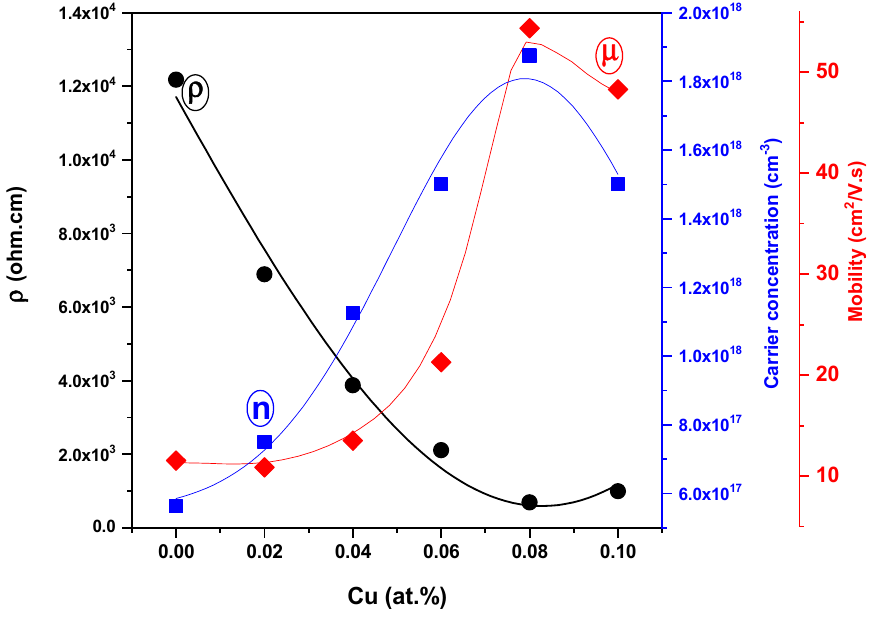
Figure 12. The resistivity ρ , carrier concentrations n, Hall mobility µ and RT of undoped and Cu-doped ZnTe film with various Cu incorporation levels.